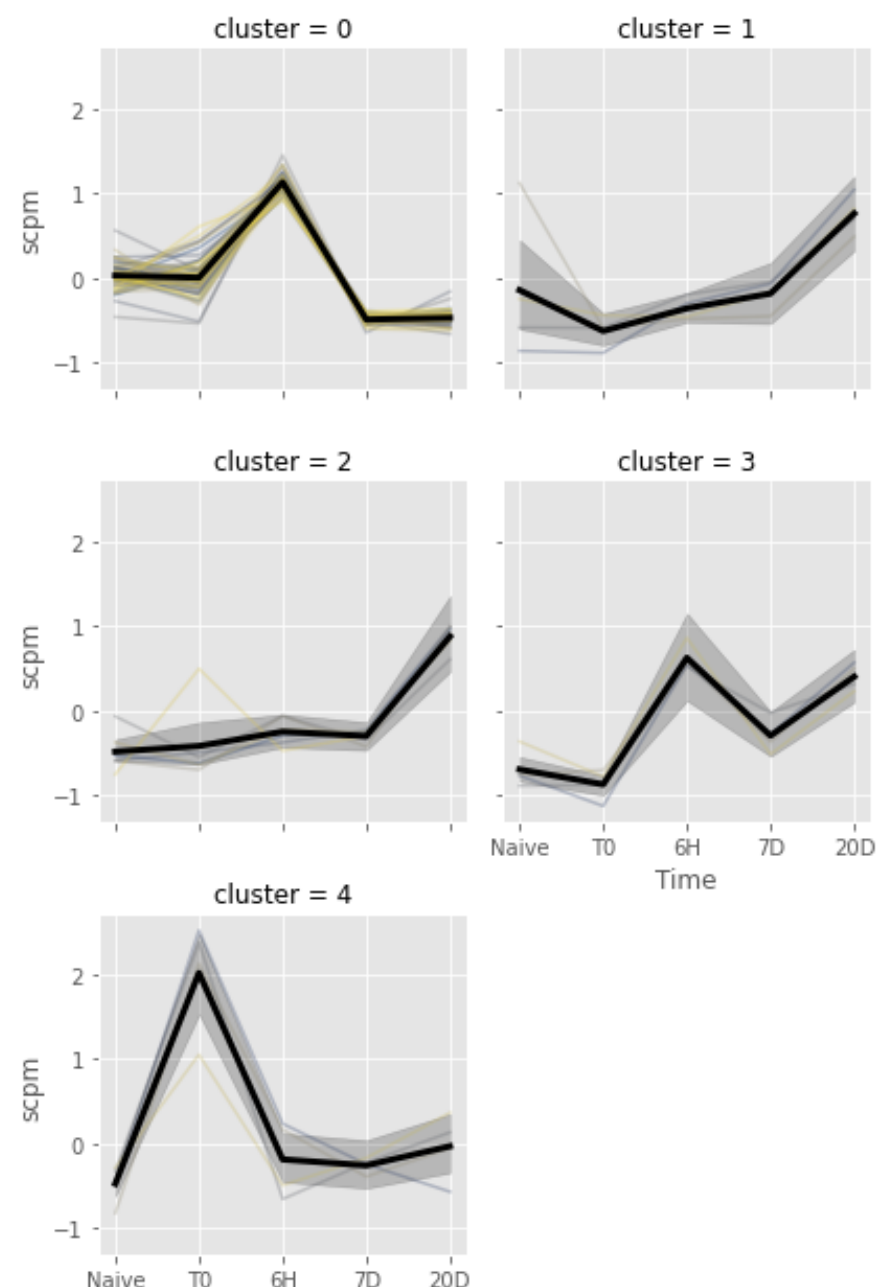
Figure 8. Spaghetti plots of gene expression patterns identified by K-means clustering of DEGs from the stabling stress test in gills. The x -axis reports the experimental time point and the y -axis reports expression levels as scaled log(CPM). The thick black line represents average, and the gray area represents the bootstrap confidence